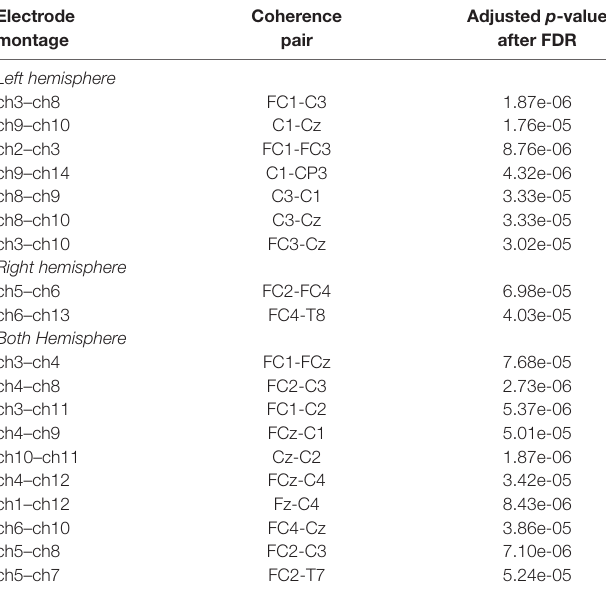
TABLE 1 | Presentation of both inter-hemispheric and intra-hemispheric coherence combinations between 22 × 22 vertices and adjusted p -values (i.e., q -values) after False Discovery Rate (FDR) computation. The top 19 vertices statistically significant combinations in which the reduction appeared during the four-task experimental paradigm are associated with the tongue motor imagery